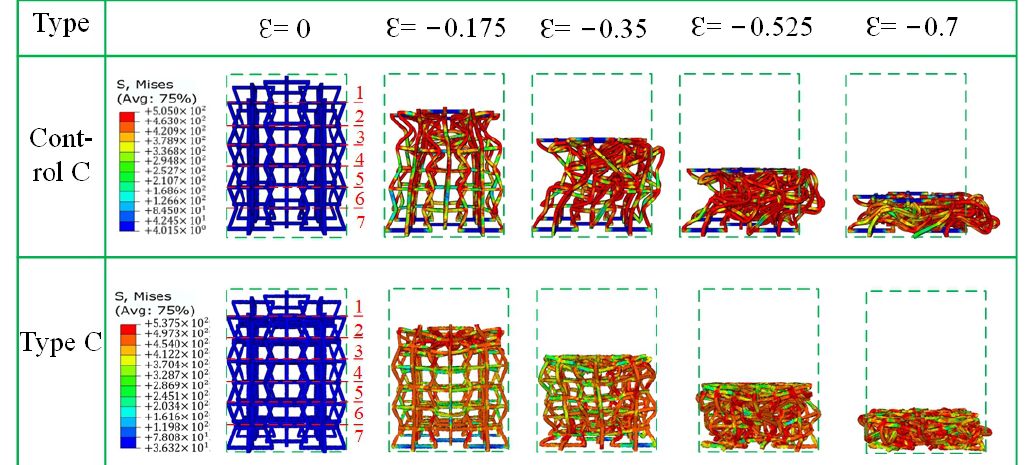
Figure 14. Fragmentation process of type C in the y